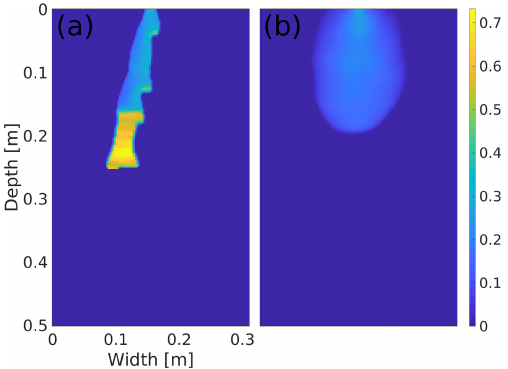
Figure 9. The role of the geometric mean of the hydraulic con- ductivity and the scaling of the retention curve. Snapshot of the saturation field for (a) the semi-continuum model and (b) without utilizing the geometric mean of the hydraulic conductivity and the scaling of the retention curve. Both simulations in panels (a) and (b) are given at t = 25min for S in = 0 . 0003. The saturation values are color coded according to the color bar on the